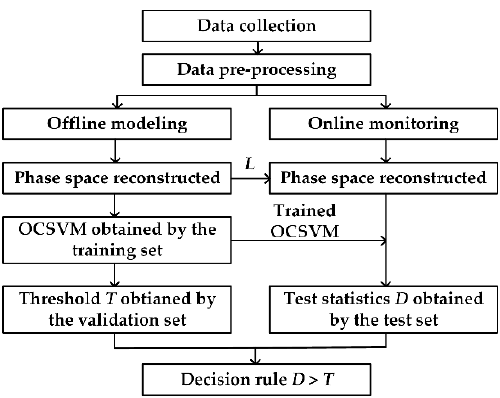
Figure 2. Overall schematic diagram of the ionospheric anomaly monitor based on the OCSVM. In data collection, we collected both the code-phase and carrier-phase